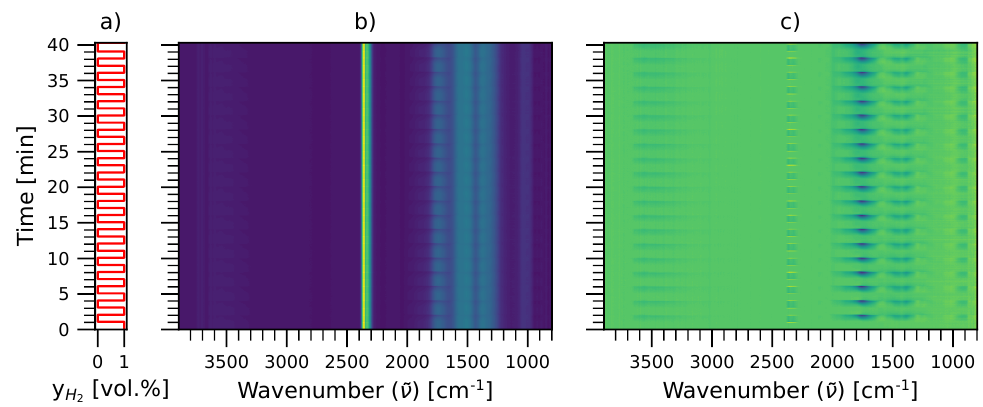
Figure 2. Modulation excitation spectroscopic measurement of CO 2 hydrogenation over a Rh/CeO 2 catalyst at 300 ◦ C showing: ( a ) the imposed H 2 concentration stimulus with period τ = 120 s; ( b ) collected background subtracted in situ infrared spectra; and ( c ) collected background subtracted in situ infrared difference spectra where the first spectrum was subtracted from each remaining spectrum in the full measured range 3900–800 cm − 1 .